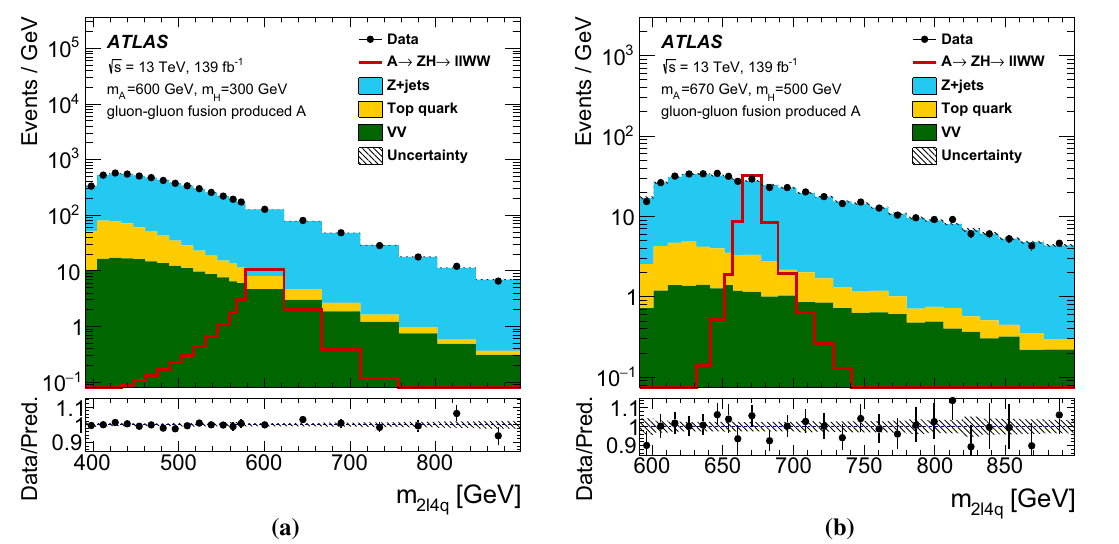
Fig. 12 The m 2 (cid:6) 4 q mass distribution for the m 4 q windows defined for a m H = 300 GeV and b m H = 500 GeV. Signal distributions are also shown with ( m A , m H ) = ( 600 , 300 ) GeV and ( m A , m H ) =